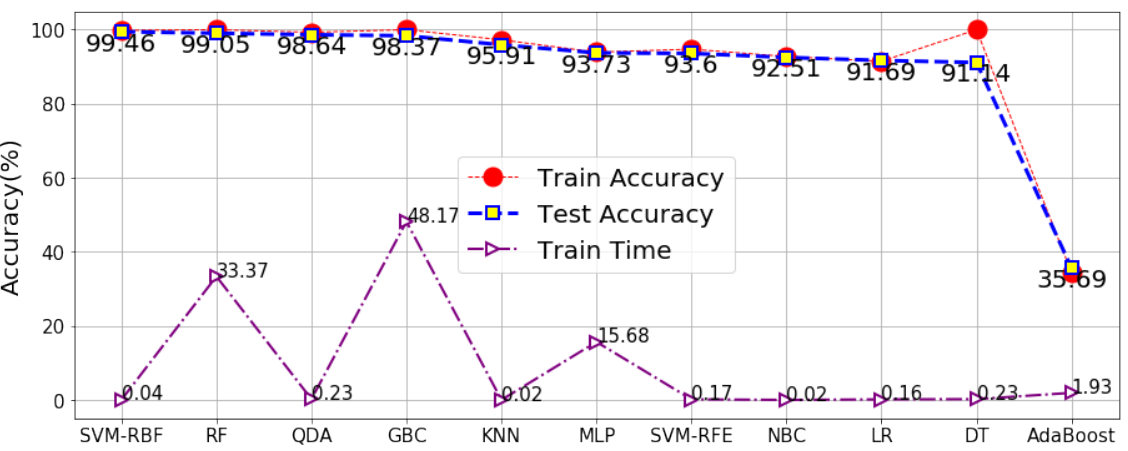
Figure 9. SVM-RBF-RFE isolation performance comparison with other classifiers. As shown, the SVM-RBF-RFE outperformed these other models based on test accuracy; however, when considering the computation cost, although not the most accurate (a